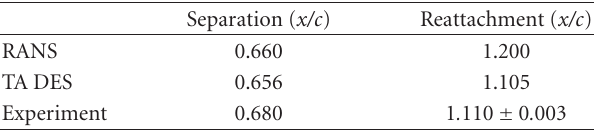
Table 2: RANS and DES